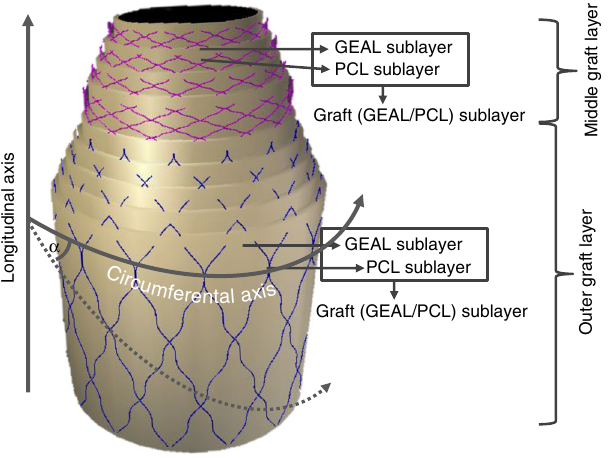
Fig. 1 Scheme composition of the middle and outer graft layers. The middle graft layer comprises a series of four poly( ε - caprolactone)/methacryloyl gelatin-alginate (PCL/GEAL) sublayers, hereafter called middle graft sublayers, with fi bres deposited at angles of + / − 21° ( + / − expresses the